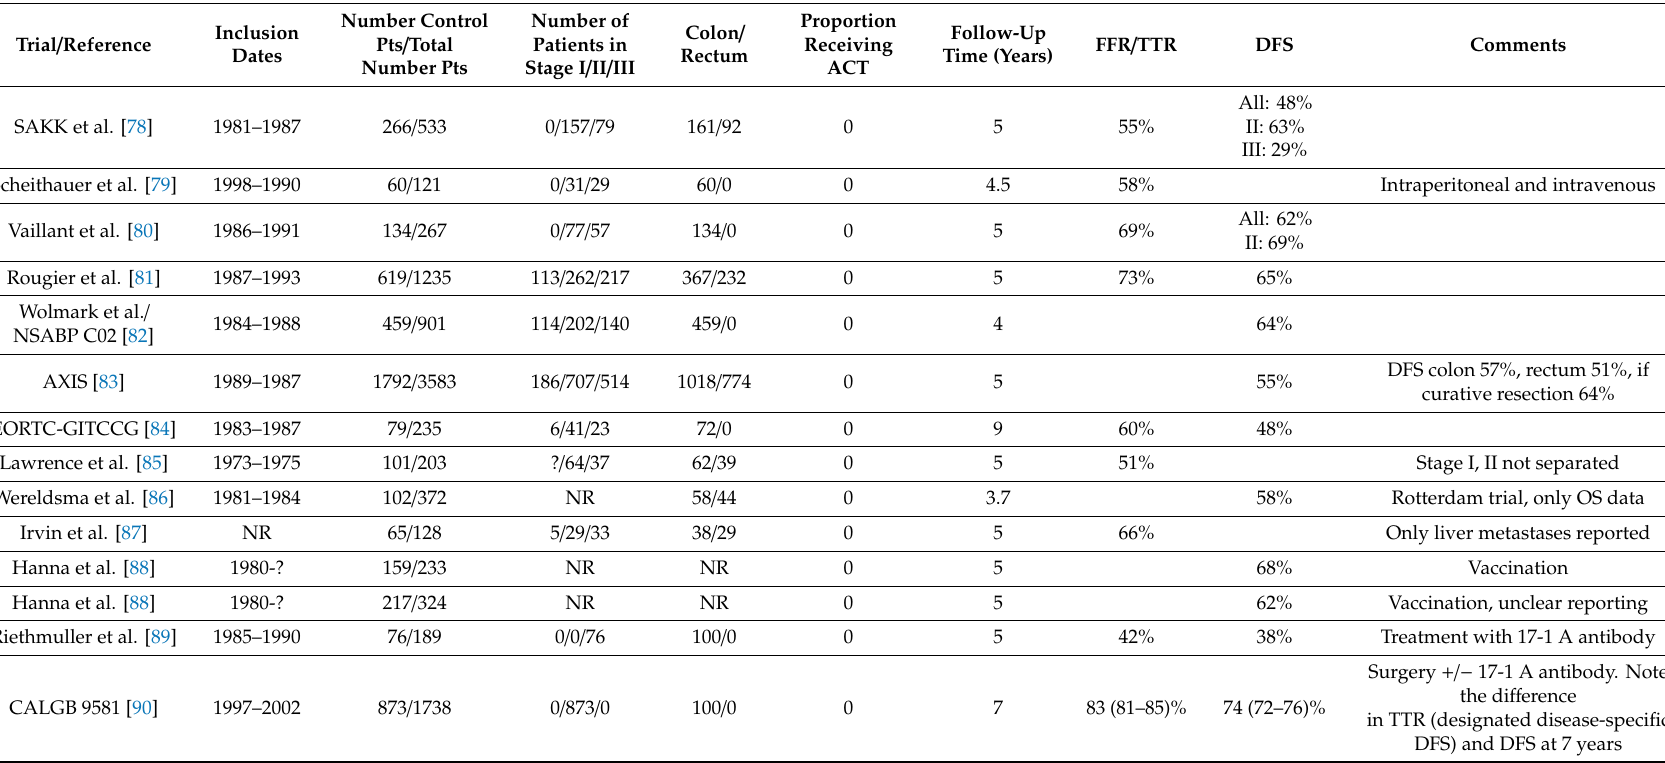
Table 2. Time to recurrence rate / freedom from recurrence and disease-free survival in adjuvant colorectal cancer trials with a control group where regional chemotherapy or miscellaneous treatments were administered in the experimental